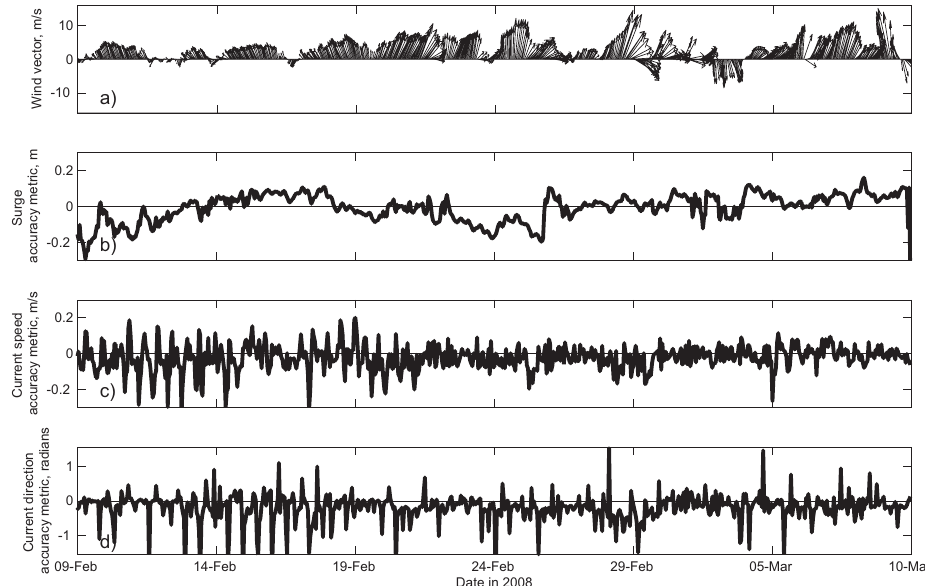
Fig. 3. Time-varying accuracy at Site A. (a) Wind vectors at this location and differential accuracy metric ( DA ) for (b) the surge, (c) the current speed and (d) the current direction. Negative values indicate the Charnock relation is performing with higher accuracy at this site than the COARE bulk wind stress formula and vice versa for positive values.